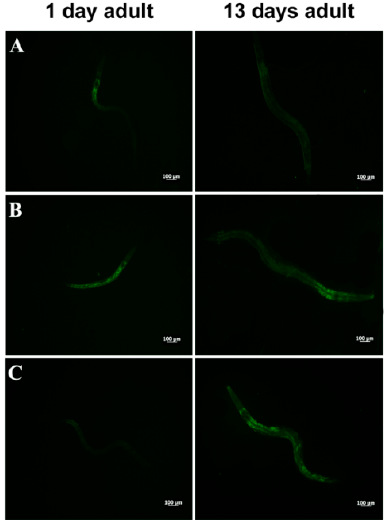
Figure 6. Visualization of lipid droplets in PEPT-1 mutants. BODIPY staining of one and 13 days adult worms grown on OP50 ( A ), LGG (B) or L. fermentum MBC2 ( C ) lawns.